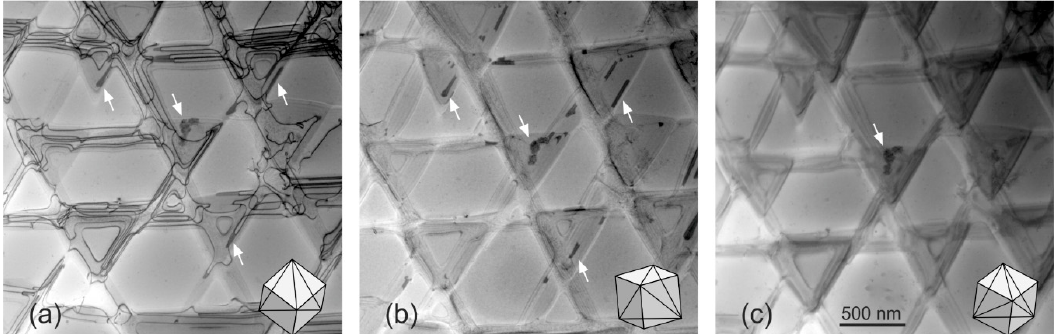
Figure 5. STEM micrographs taken after 1% strain accumulated in the 011 111 [ ]( ) shear creep system at 750 °C and 300 MPa. ( a ) g7 = 111 ( ) : 1/2 011 [ ] -type dislocations and stacking faults (SFs) in full contrast. ( b ) g2 = 111 ( ) : 1/2 011 [ ] -type dislocations out of contrast, SFs in contrast. ( c ) -g9 = 311 ( ) : 1/2 011 [ ] -type dislocations and SFs out of contrast. Nine STEM images of the cutting event highlighted with the white arrow in Figure 4b are shown in Figure 6a–i. They were taken using different contrast conditions ( g -vectors) after macroscopic 112 111 [ ]( ) shear creep deformation to 1% (750 °C, 300 MPa). Stereo microscopy was used (images not shown) in order to clarify the spatial arrangement of individual dislocation segments [19,21].